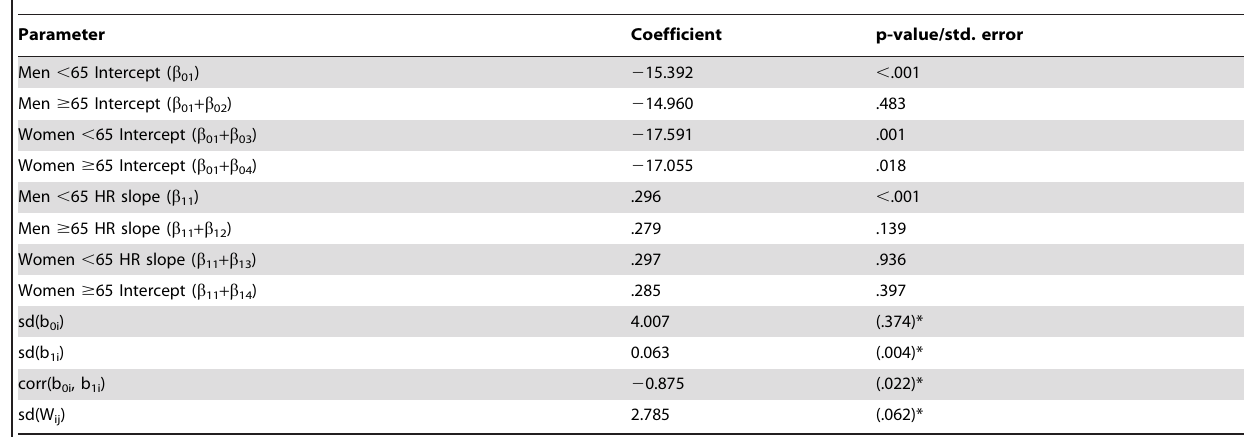
Table 2. Stratified Model 1 Parameter Estimates.